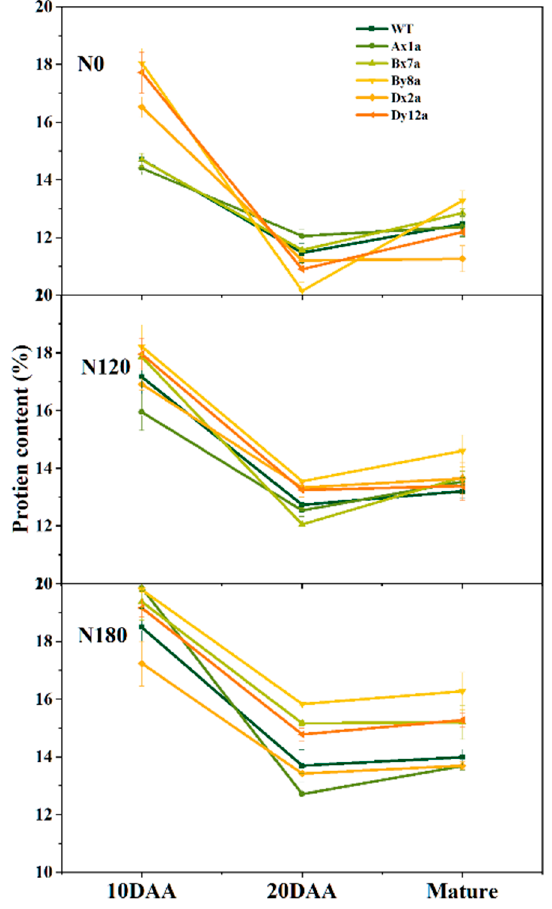
Figure 4. Dynamic changes in total protein content of grains in wheat lines with the absence of HMW-GS during grain development under different N treatments in 2017–2018 wheat growing season.